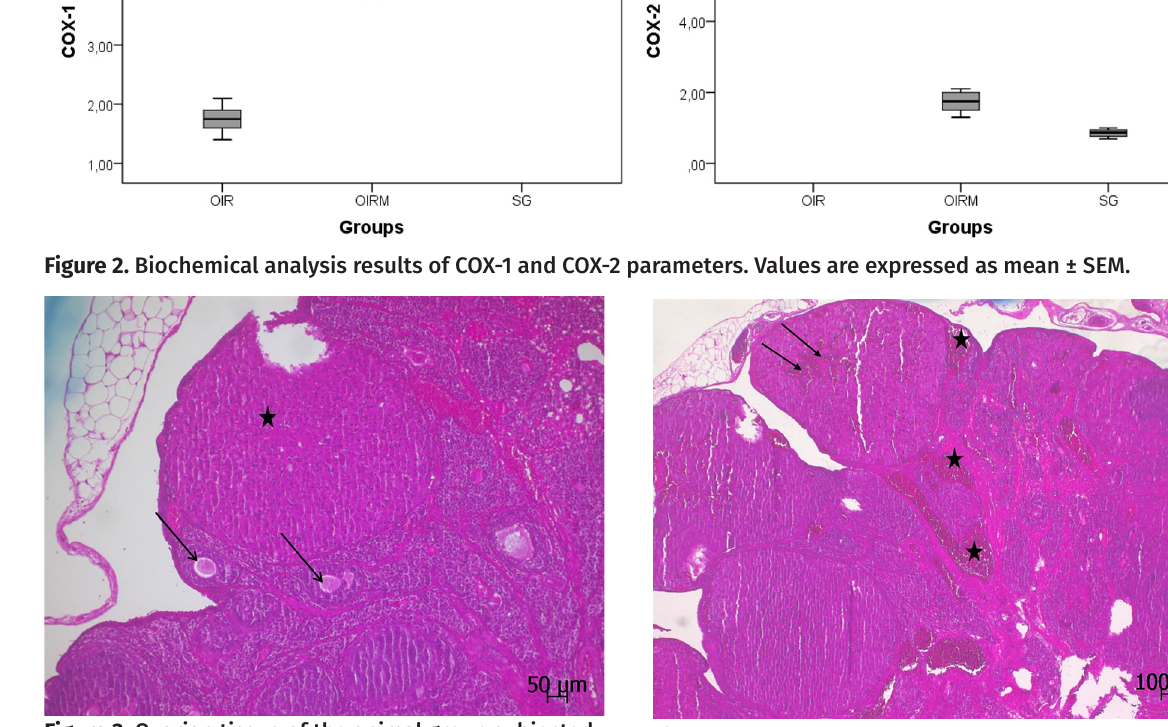
Figure 4. Ovarian tissue of the OIR group displays extensive congestion (star) and severe hemorrhage (arrows)